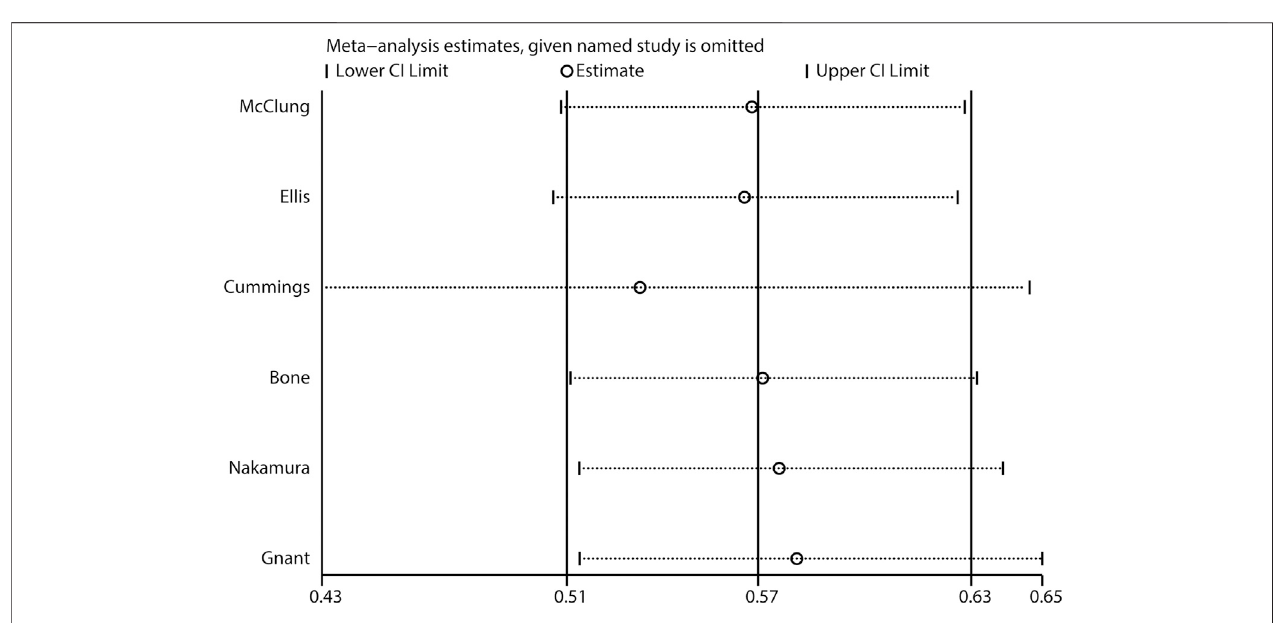
FIGURE 4 | Sensitivity analysis of clinical fractures.